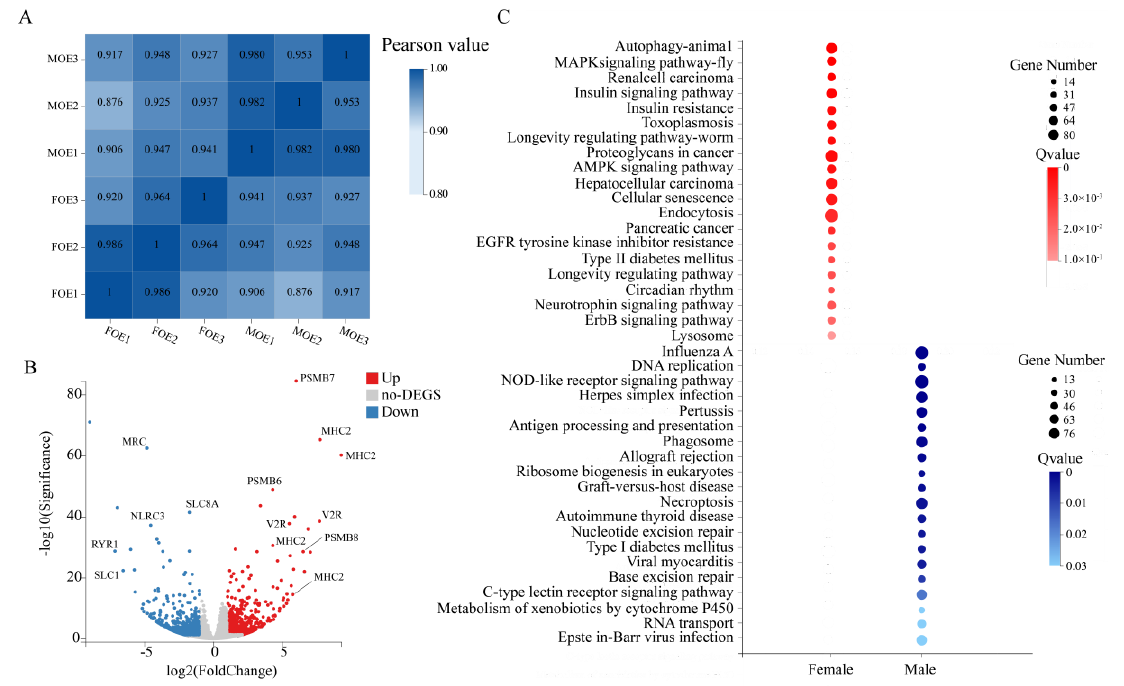
Figure 3. Sexual dimorphism in blunt snout bream olfactory system. ( A ) Heat map of cross-correlations of all samples using transcripts. ( B ) Log2-fold change between male and female samples is plotted against their − log10 FDR. ( C ) KEGG pathway enrichment of differentially expressed genes between OE of male and female blunt snout bream.